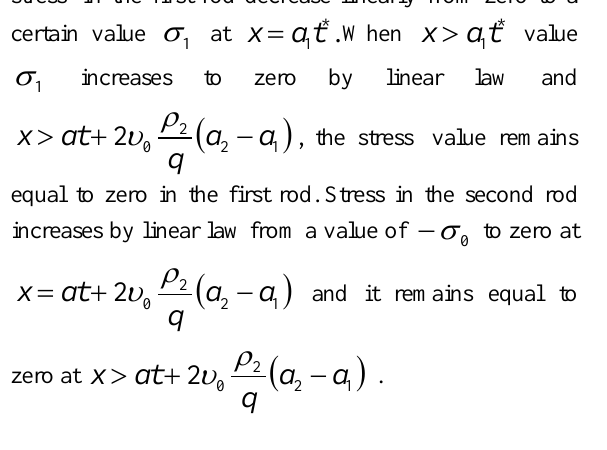
Fig. 9b. Dependence of the stresses on the